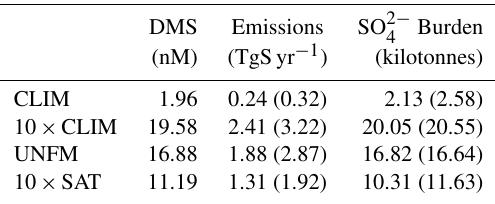
Table 1. Arctic mean surface seawater DMS concentration, total sulfur emission flux, and associated mean biogenic sulfate burden for 2000